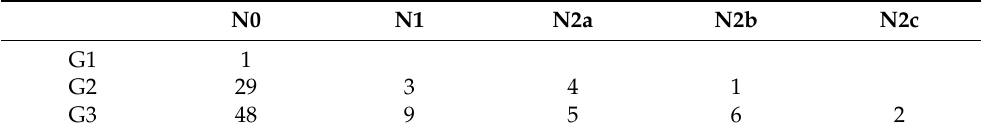
Table 2. Distribution of the N stage in the population with respect to the grading. N0 N1 N2a N2b N2c G1 1 G2 29 3 4 1 G3 48 9 5 6 2 The average NLR level was 2.15 (1.13–5.64) for the PN0 group and 2.87(1.24–6.13) for the PN+ group ( p < 0.01 at the Kruskal–Wallis test, Figure 1). The average PLR level was 119.25 (46.64–274.68) for the PN0 group and 136.81 (82.53–272.22) for the PN+ group